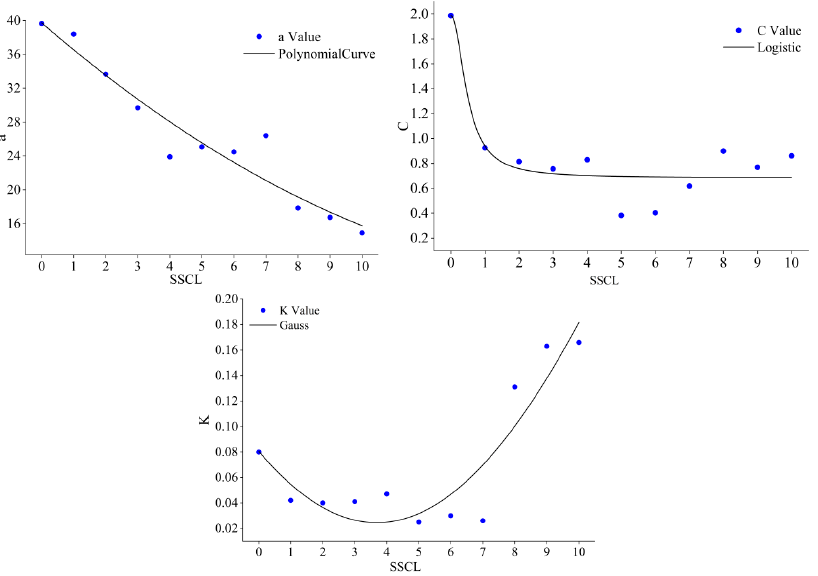
Figure 4. The relationship between the parameters of the DBH growth equation and the